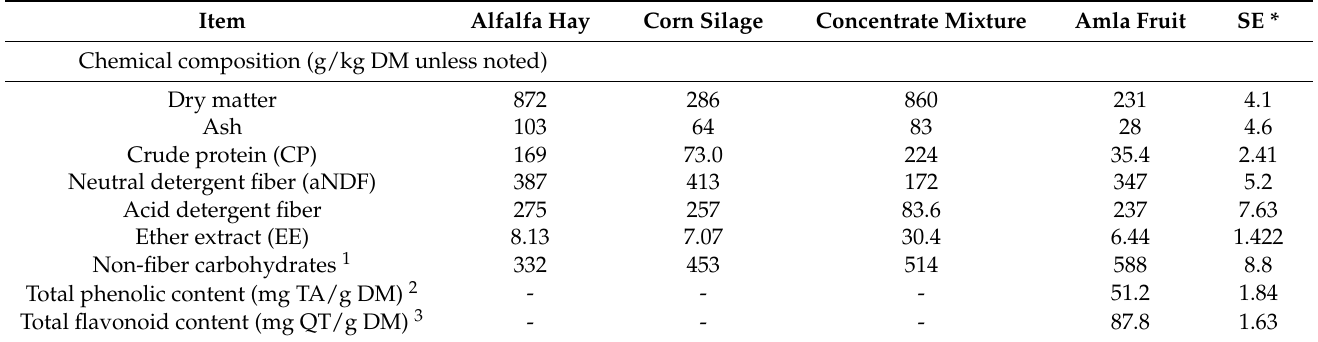
Table 2. Chemical composition of individual total mixed ration (TMR) ingredients and additive fresh amla